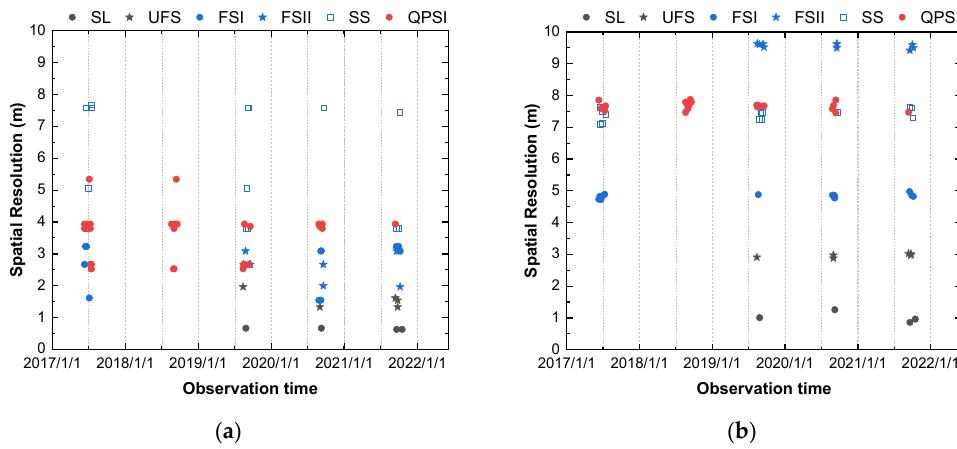
Figure 6. GaoFen-3’s spatial resolution evaluation on single-pol, dual-pol, and quad-pol datasets for the Inner Mongolia calibration site from June 2017 to October 2021. ( a ) Spatial resolution results in the range direction; and ( b ) results in the azimuth